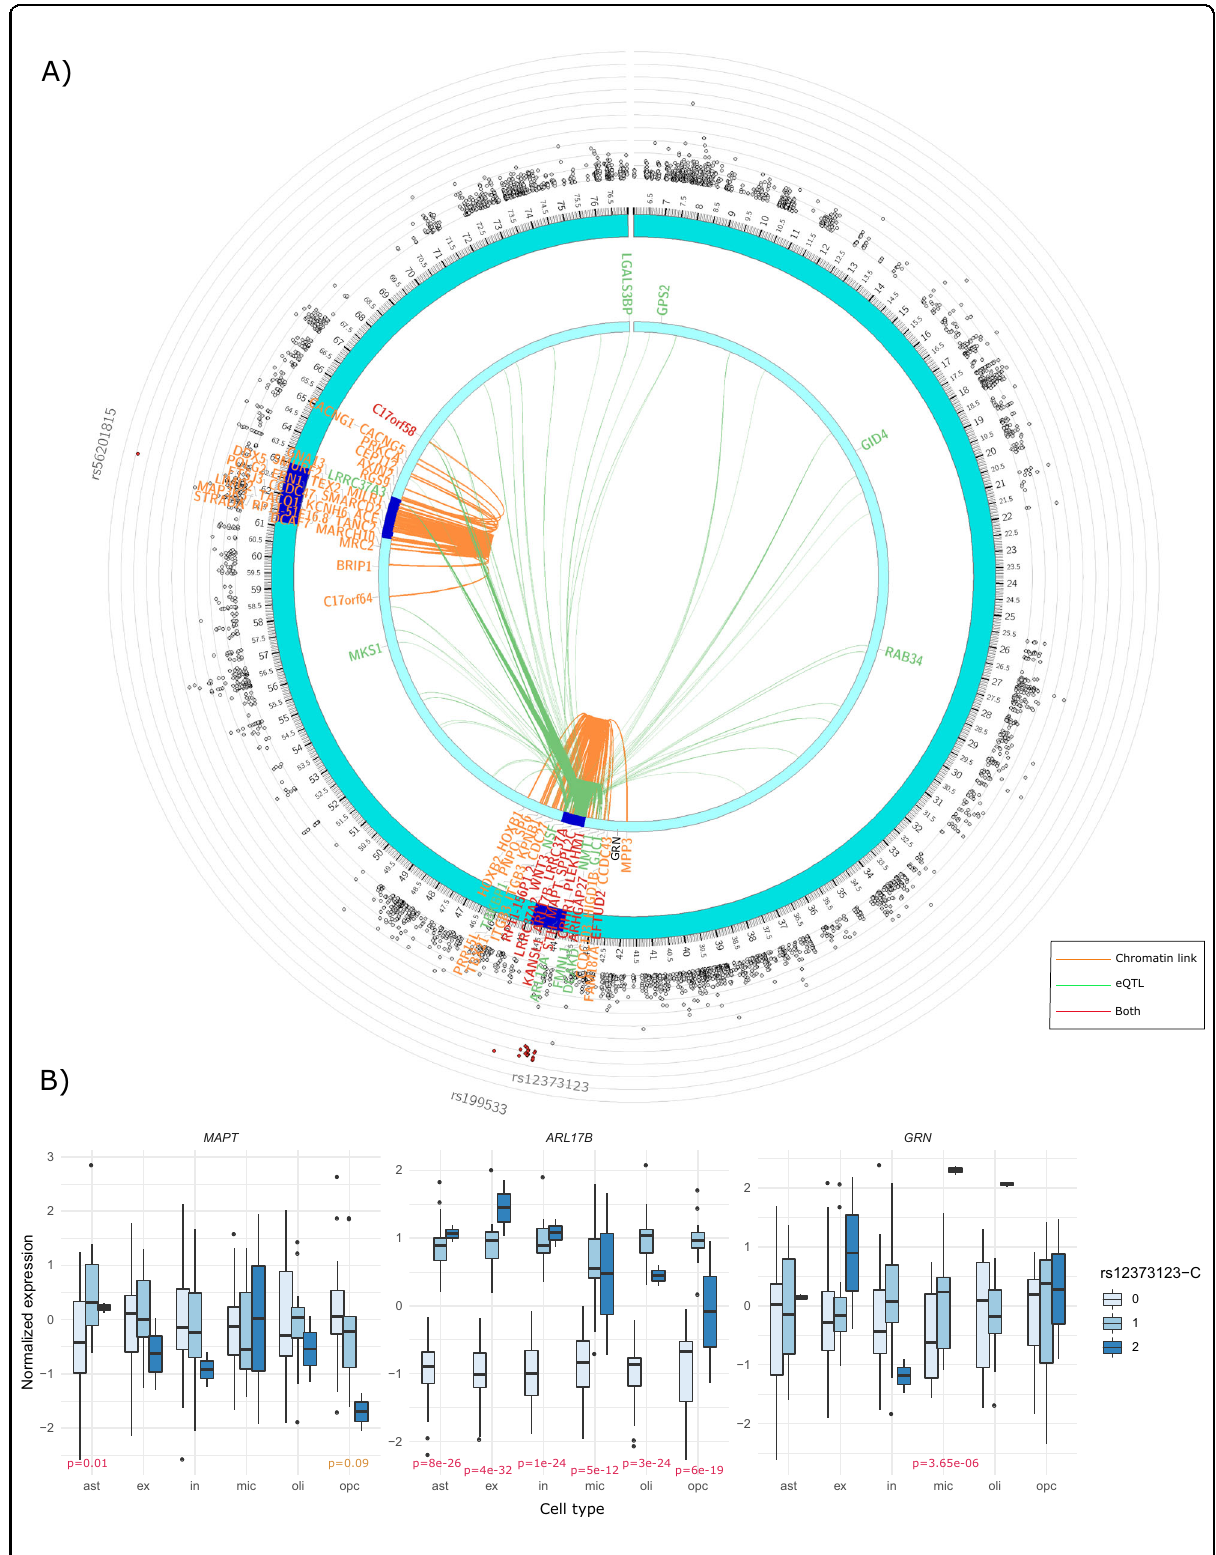
p=3.65e-06p=0.01